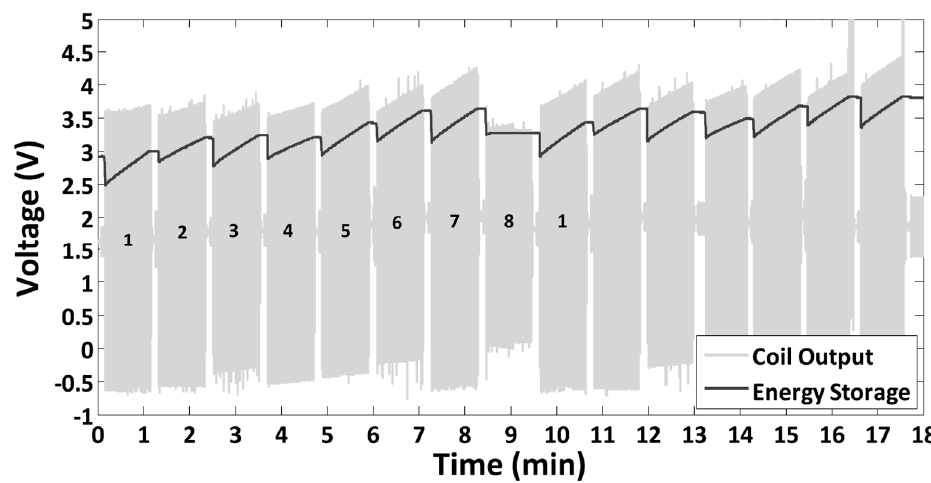
Figure 10. Voltage of the energy storage and coil output voltage of the physical system in Ref. [25].